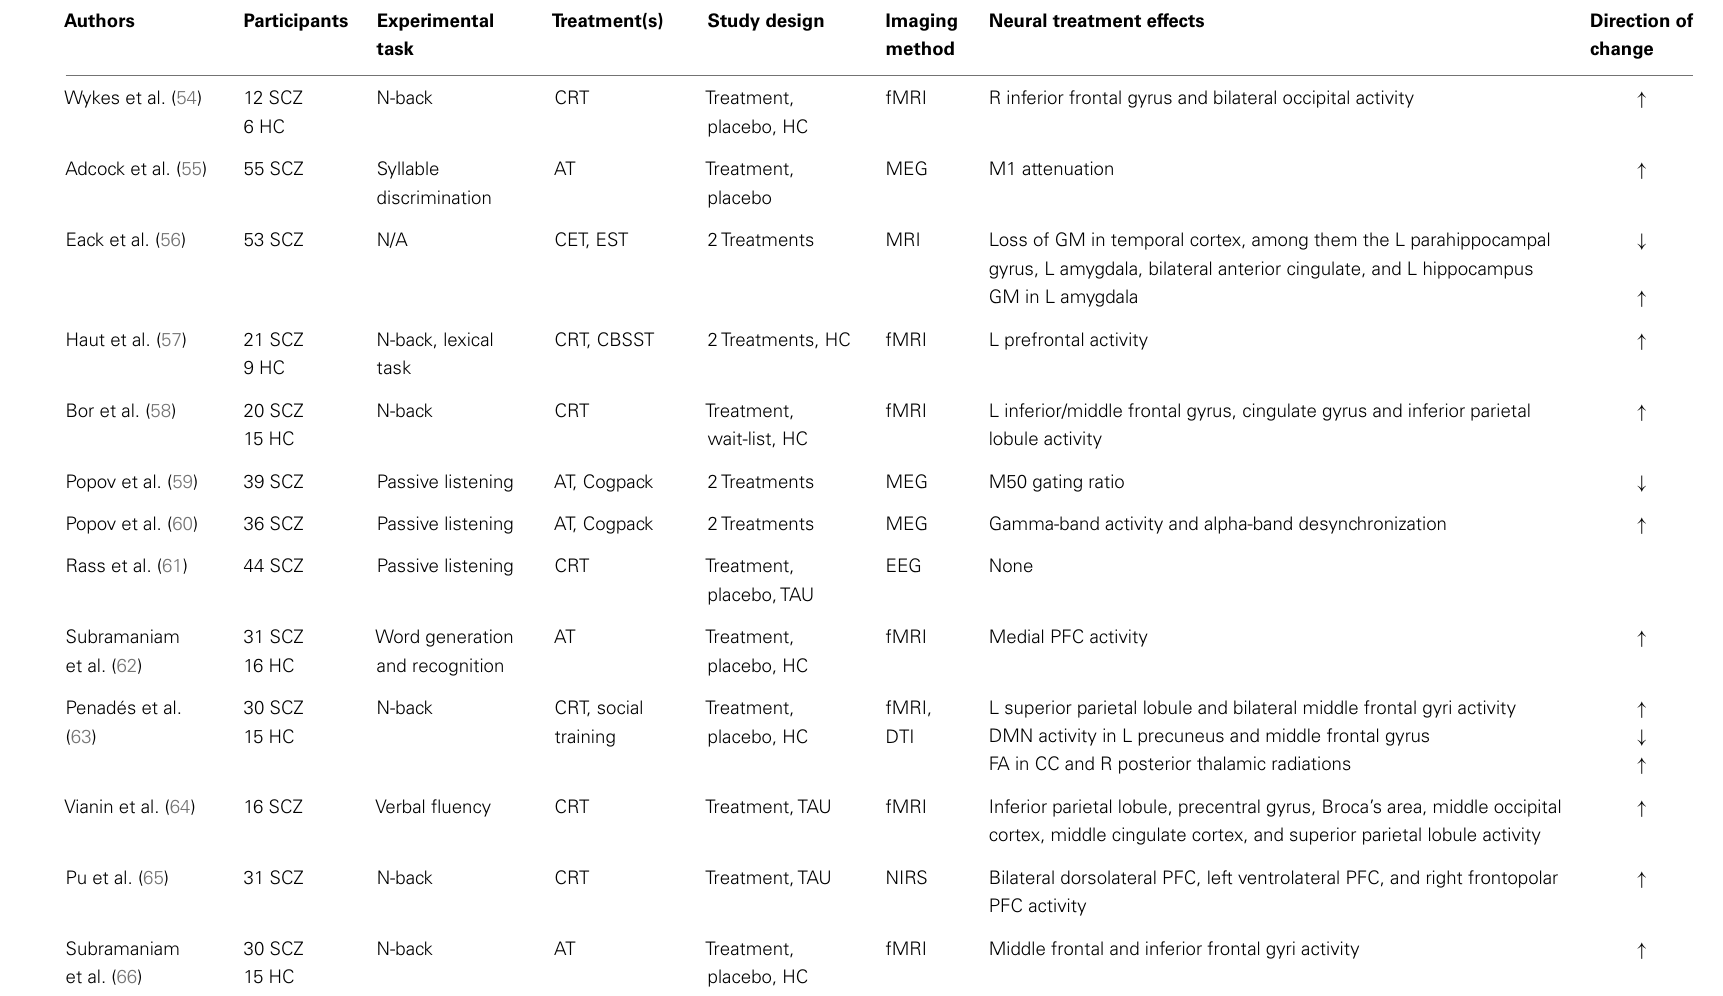
Table 1 | Summary of the reviewed studies